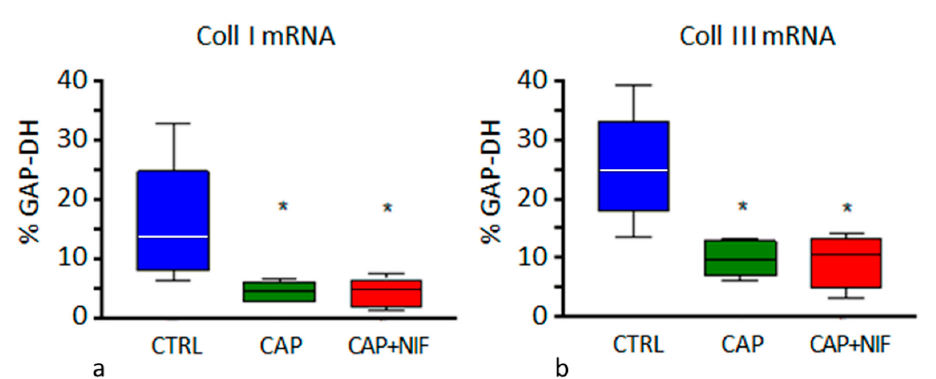
Figure 5. Coll I ( a ) and Coll III ( b ) mRNA expression (in % of GAP-DH) in the LV. Data are given as median (line in the box) with 25th/75th percentiles (boxes) and 10th/90th percentiles (whiskers). All values were obtained from 82-week-old SHR. Significance marks: * significant vs. CTRL ( p < 0.001).